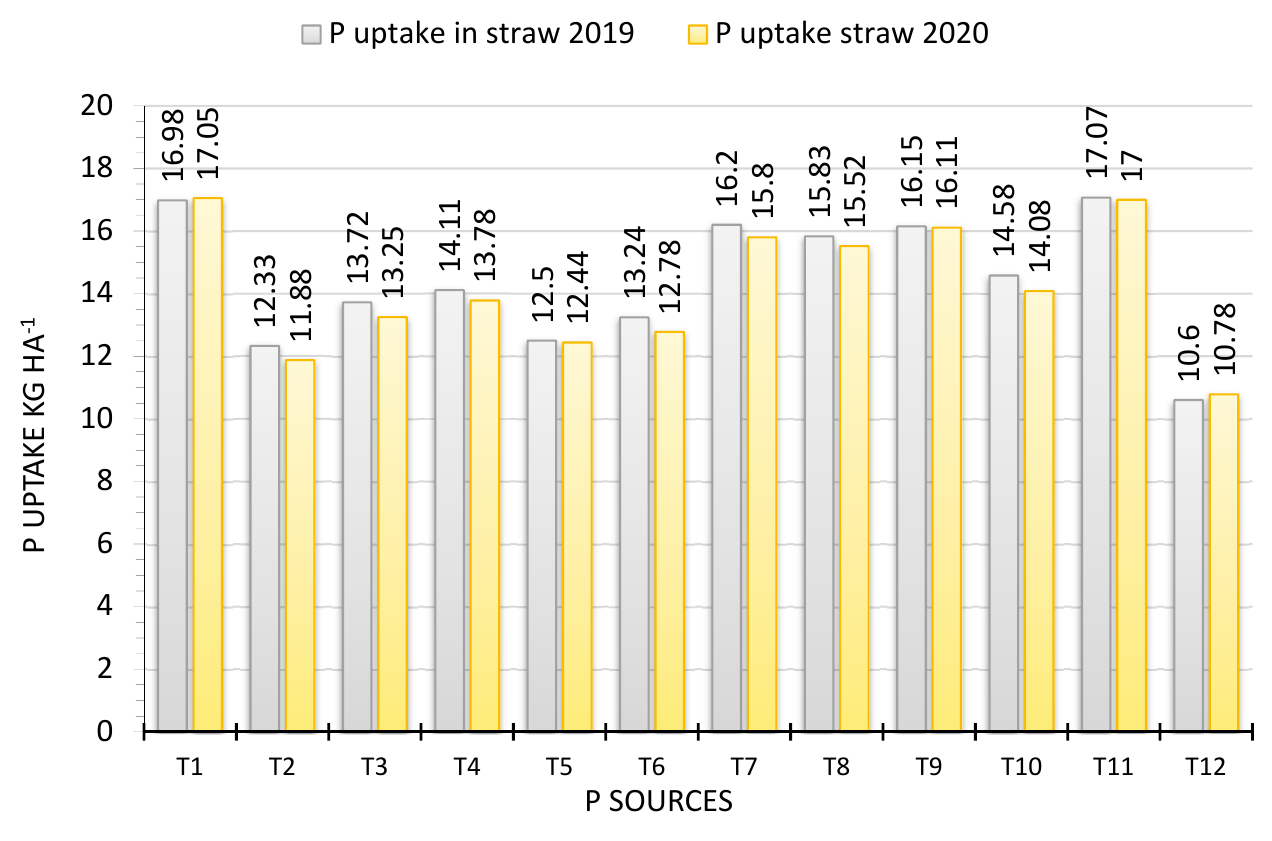
Figure 3 . Phosphorus uptake in straw of Sakha 106 rice cultivar was affected by arbuscular mycor- rhizal fungi, phosphate-solubilizing bacteria and selected chemical phosphorus fertilizers following the application of different P sources in the 2019 and 2020 seasons. SSP, single super phosphate (15% P2O5); PSBs, phosphate-solubilizing bacteria; AMFs, arbuscular mycorrhizal fungi; PNPs, phospho- rus nanoparticles; PA, phosphoric acid. T1, basal application of 100% single super phosphate (SSP)